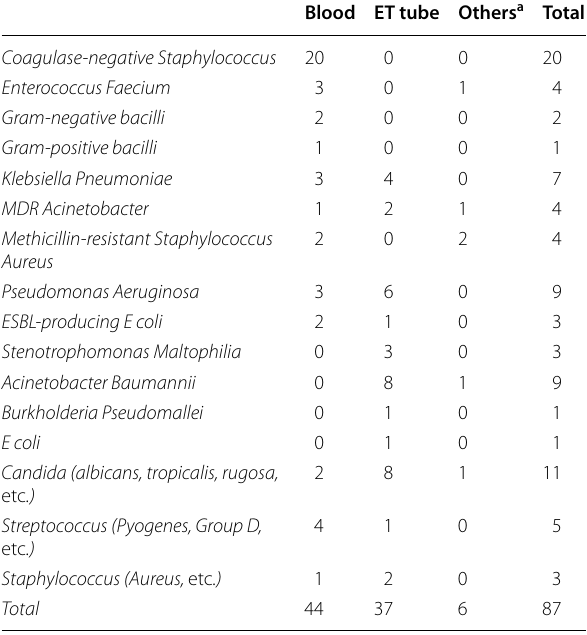
Table 2 Positive culture growths of 47 patients hospitalised with